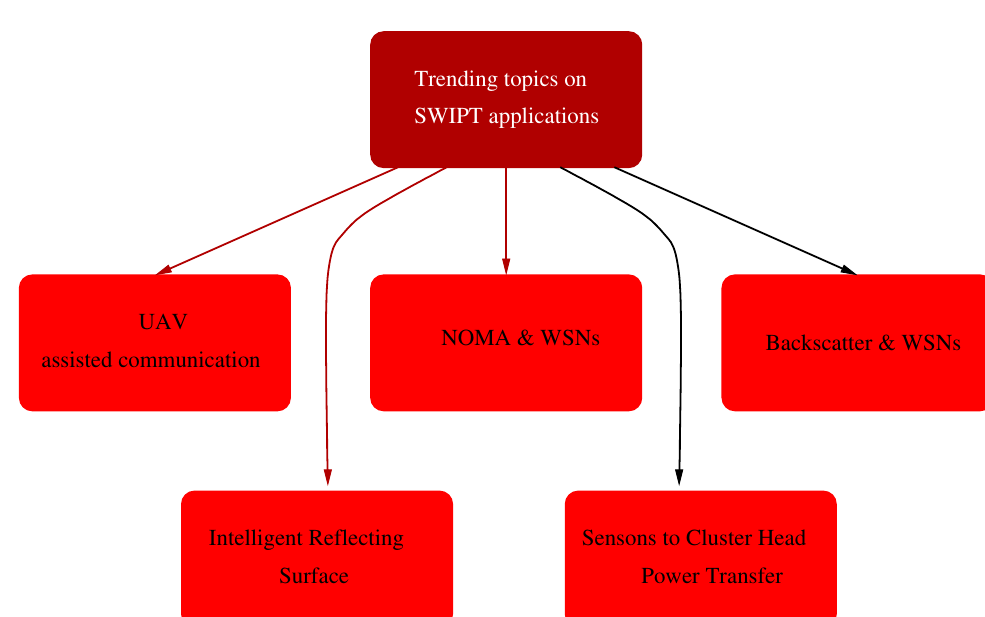
Figure 7. Trending topics in research about SWIPT/WPT in